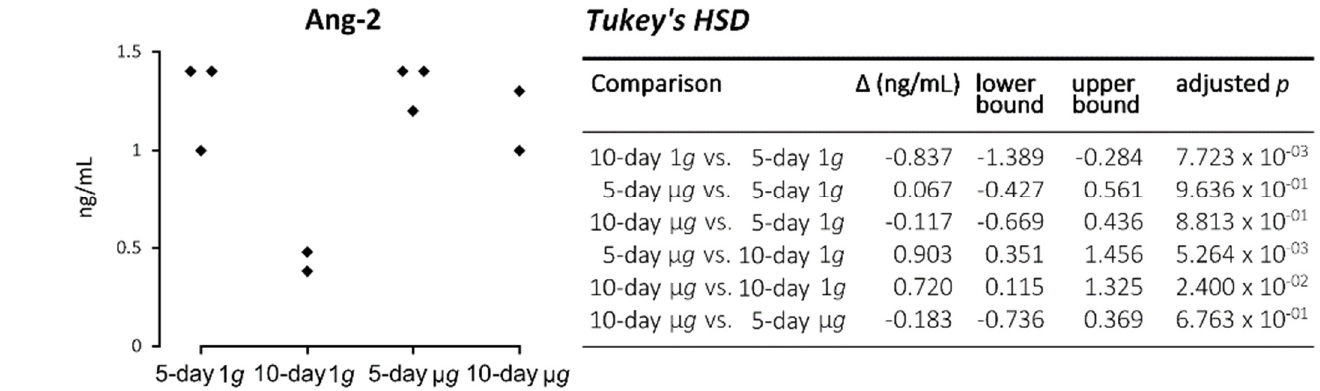
Figure 6. Angiopoetin-2 (Ang-2) MAP analytes concentration and statistical evaluation.